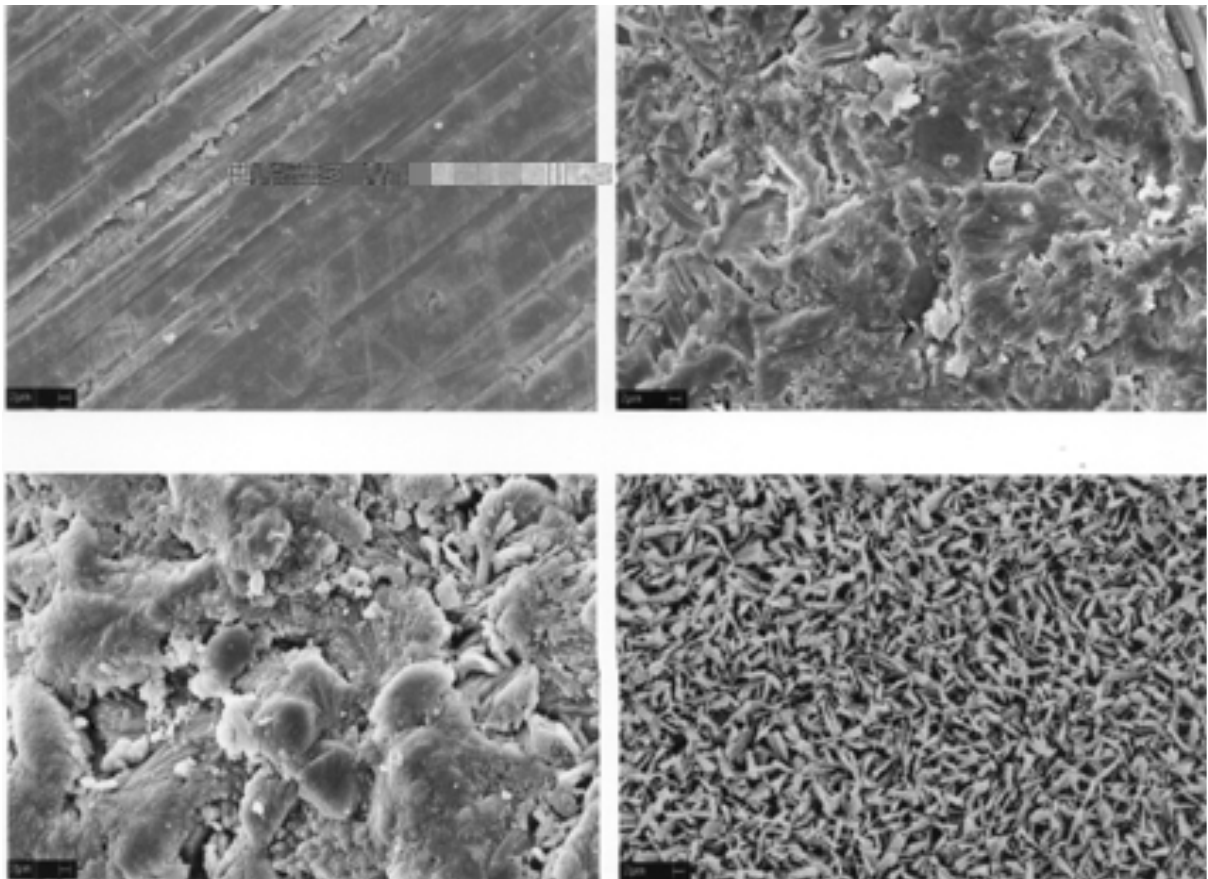
Figure1. SEMpictureshowingthesurfaceoftheimplant:(x3.000).a)as-machined;b)Al 2 O 3 blasted;c)plasma-sprayedwithtitanium;d)electrolitically coated with hydroxyapatite.